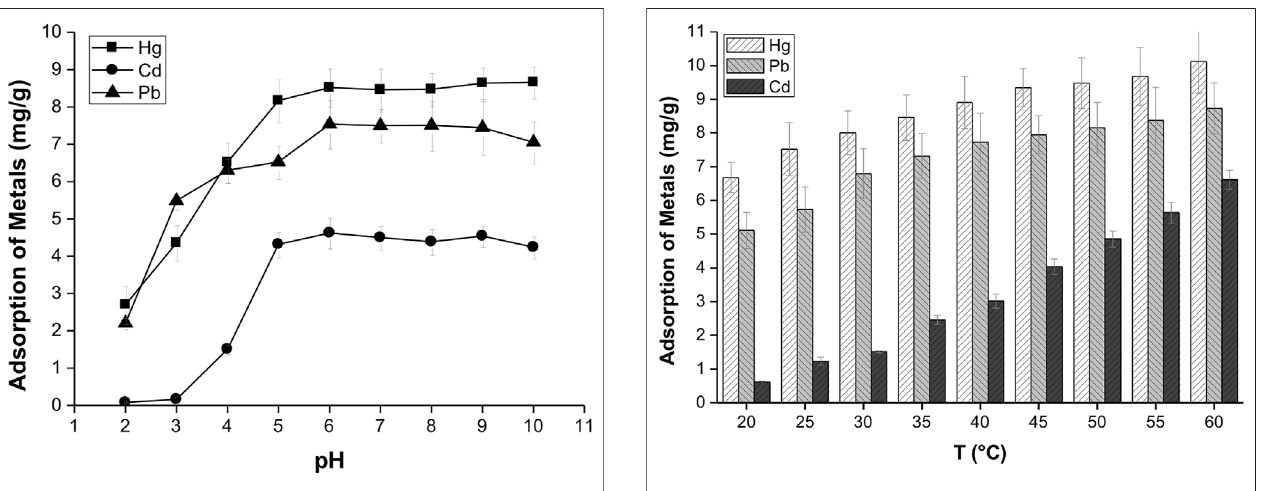
FIGURE 5 | Effect of temperature ( ° C) in Pb (II), Cd (II), and Hg (II) adsorption at 51.5 mg L − 1 with Penicillium sp . biomass.